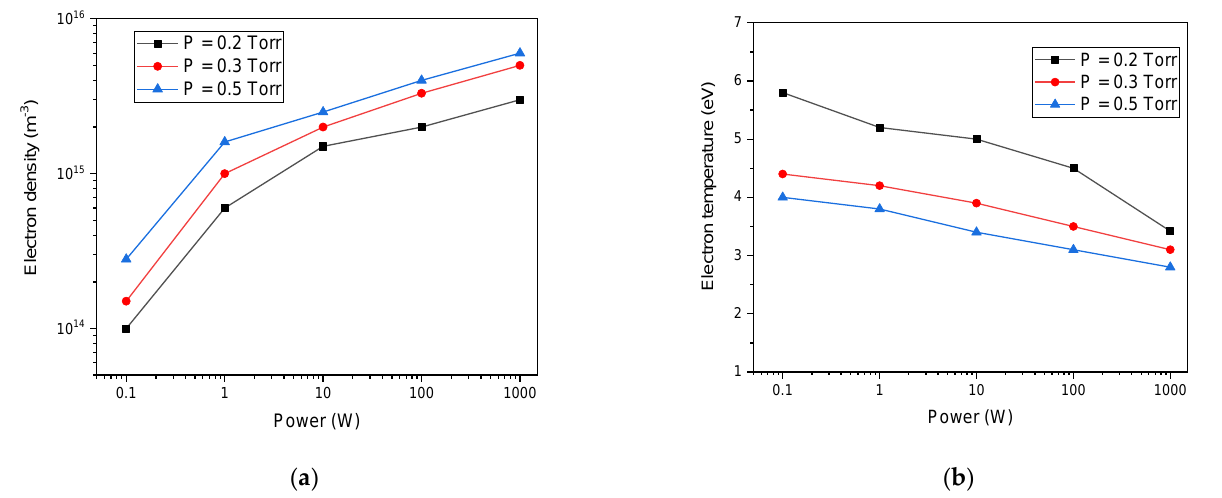
Figure 11. ( a ) Electron density and ( b ) electron temperature as a function of input power in Ar/O 2 at different working pressures (P = 0.2 Torr, 0.3 Torr, and 0.5 Torr) and (20%) O 2 .